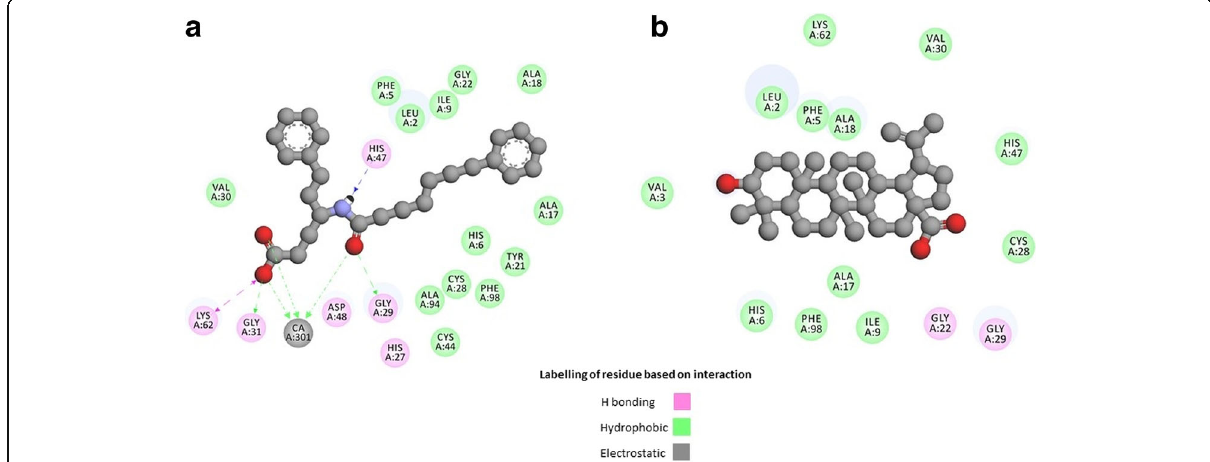
Fig. 3 Interaction of ( a ). BR4 (gray) and ( b ). BA (gray) with PLA2 visualized in Drug Discovery